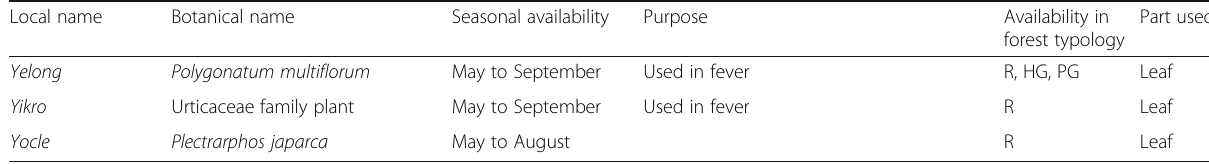
Table 3 Use of major ethnobotanicals by Adi community in remote locations to sustain life (Continued)